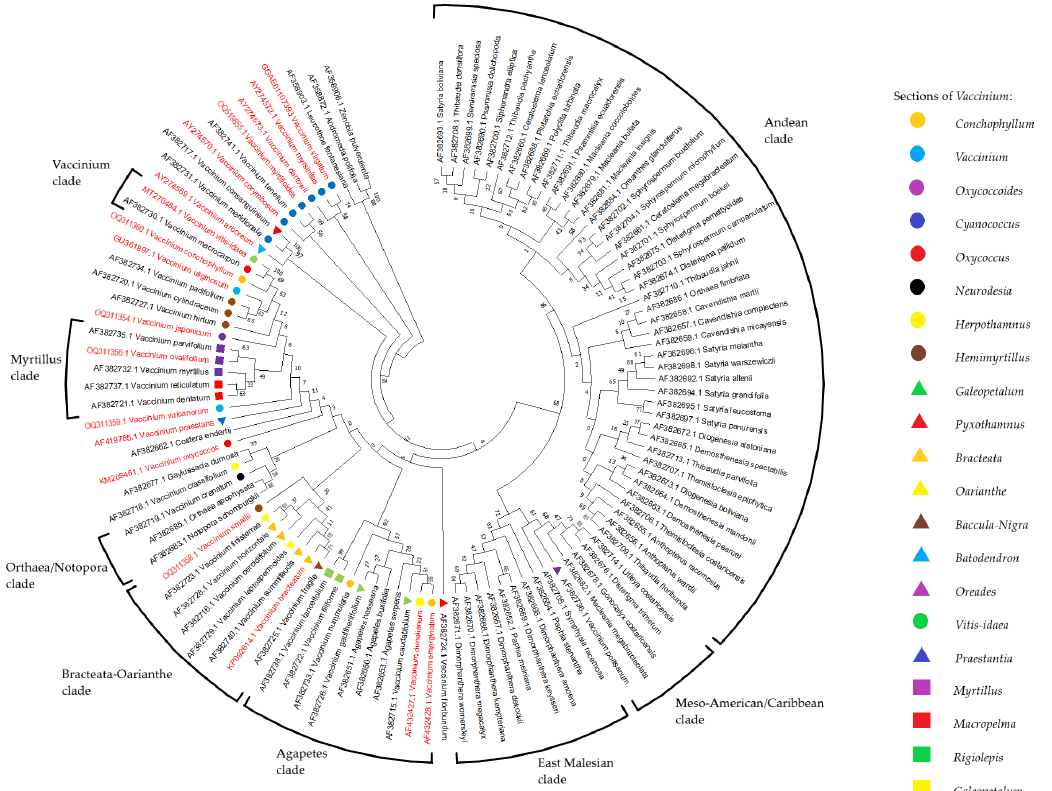
Figure 6. Molecular phylogenetic analysis of tribe Vaccinieae based on ITS sequences using Maxi- mum Likelihood method and General Time Reversible model (There were a total of 651 positions in the final dataset). Species with sequences obtained by us are highlighted in red.